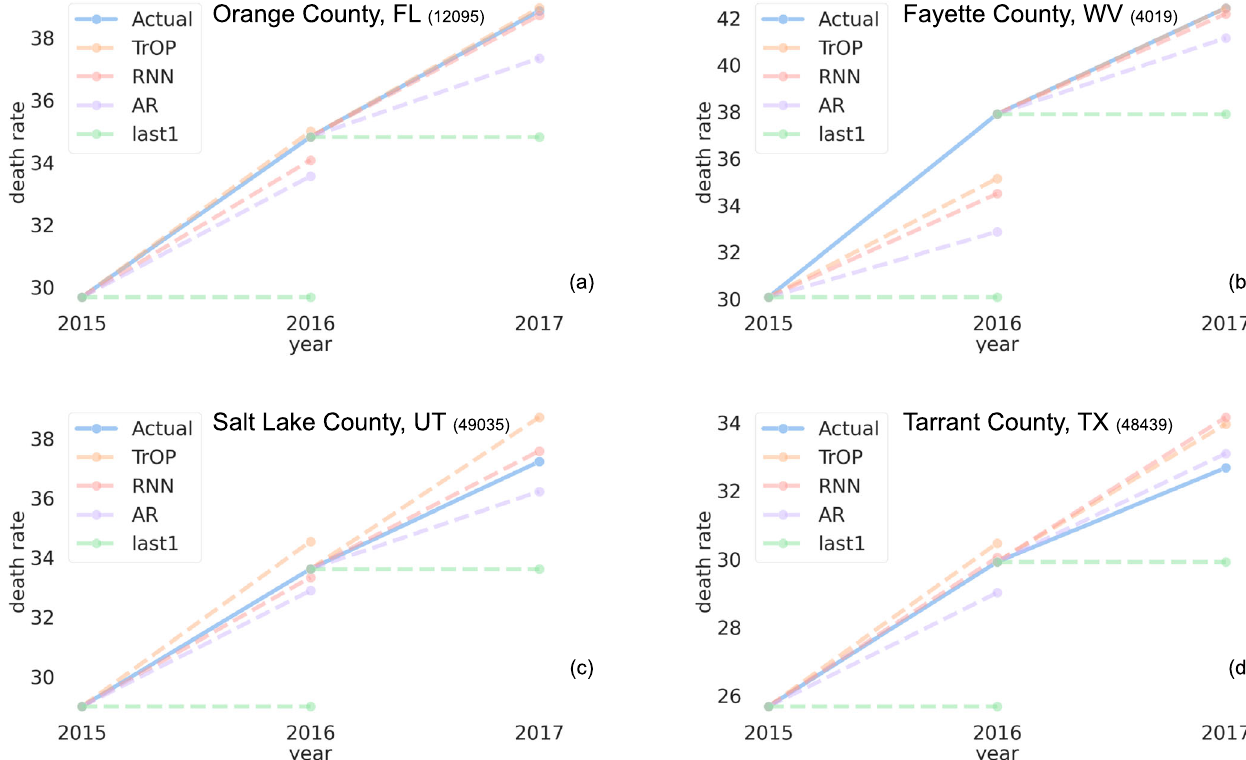
Fig. 1 Forecasting model error for selected counties. Visualization of forecast errors, in deaths per 100,000, for all of our machine learning models as well as the last 1 baseline. We highlight 2 counties where T R OP performed best, Orange County, FL ( a ) and Fayette county, WV ( b ), as well as 2 counties where the RNN and linear model are each best, Salt Lake County, UT ( c ) and Tarrant County, TX ( d ),